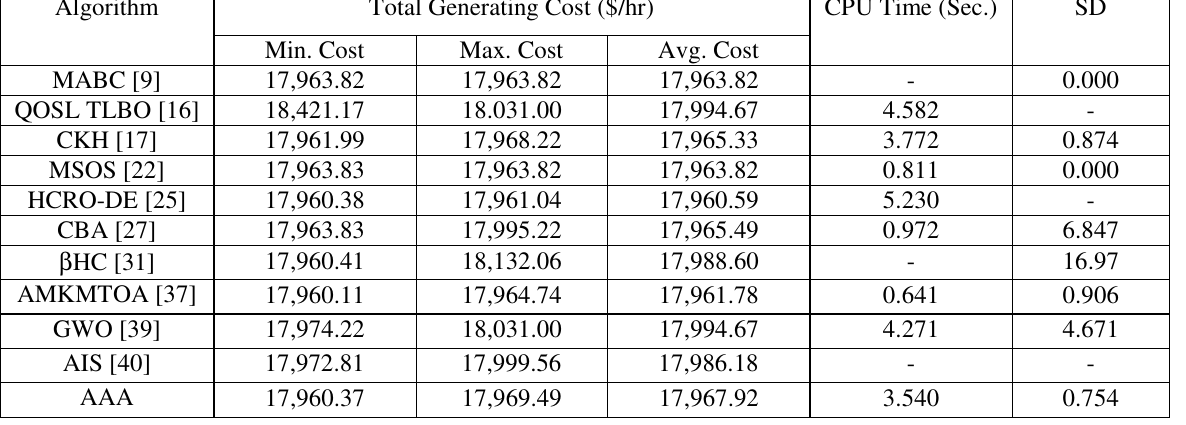
TABLE 3: COMPARISON OF RESULTS FOR TEST CASE 3